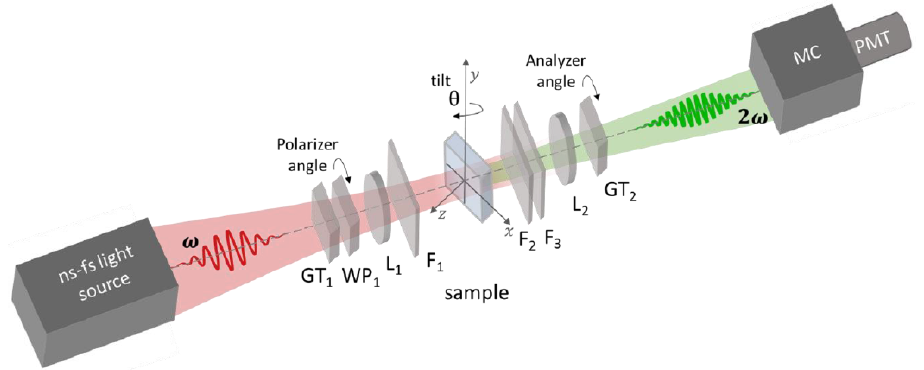
Figure 5. Typical SHG measurement setup in transmission. The incident probe beam is linearly polarized by a Glan-Taylor prism (GT 1 ). The polarization of the probe beam is then set to an arbitrary polarization state by a rotatable wave-plate. WP 1 can be a half-wave-plate for linear polarization states or a quarter-wave-plate to achieve circular polarization. The spot size on the sample is controlled by a focusing lens L 1 . Low-pass filter F 1 removes any second harmonic light generated in the polarization optics before the sample. The fundamental beam and higher order harmonics are blocked by band/high-pass F 2 and low-pass F 3 filters. The SHG light is collected by L 2 , and the polarization state is analyzed by projection on a second, rotatable, GT prism (GT 2 ). The SHG intensity is integrated after passing a monochromator (MC) and photomultiplier tube (PMT). In the case of spatially-resolved SHG, L 2 is exchanged for a (microscope) objective lens and the detection unit is replaced with a CCD camera. The incident angle θ can be changed by rotating the sample around the y